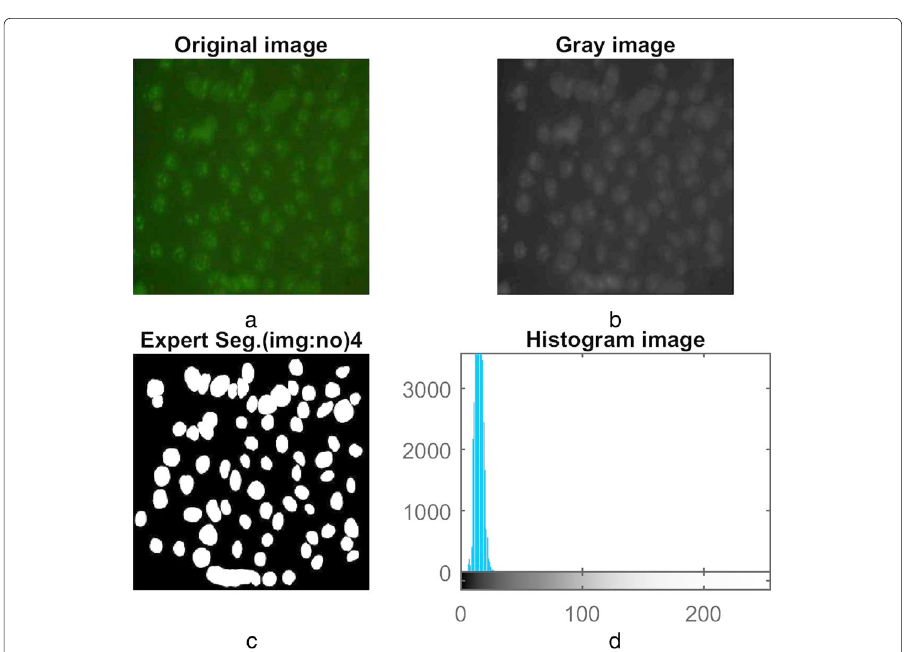
Fig. 3 a Original image. b Its gray level. c Expert segmentation. d Image